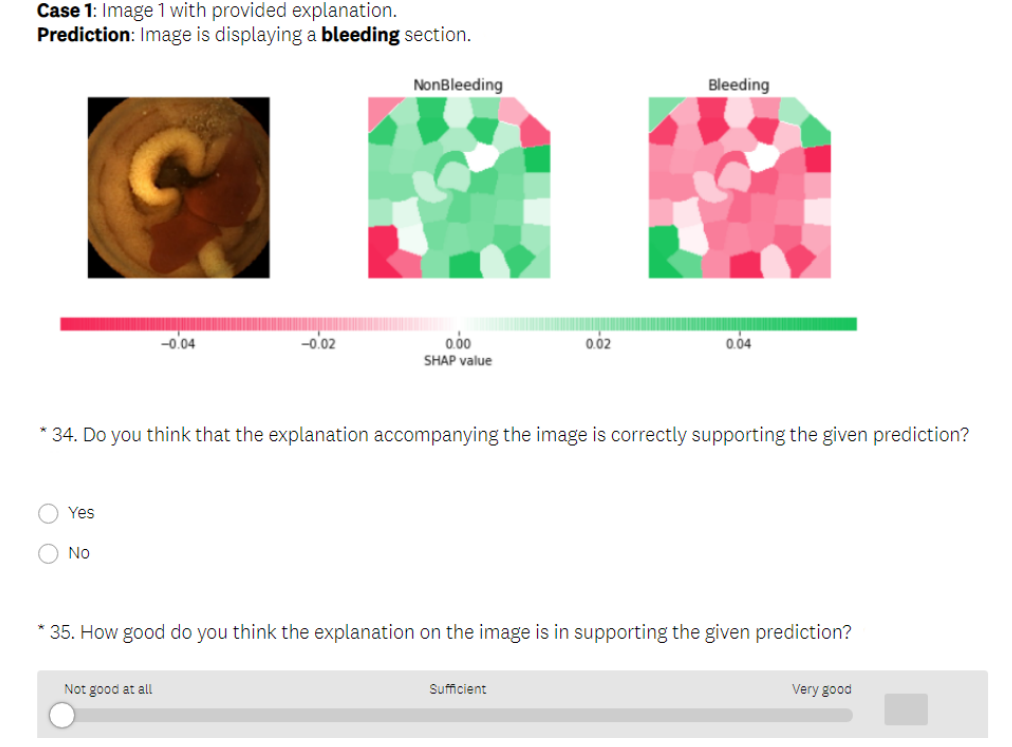
Figure 18. Incorrect SHAP explanations in the user